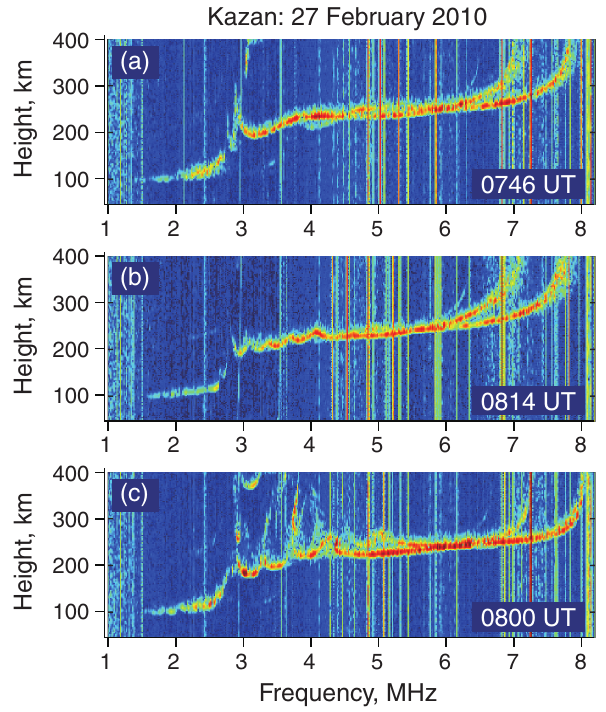
Figure 2. Ionograms obtained at Kazan showing unperturbed traces (a) , weak coseismic disturbances (b) , and a significant anomaly due to large amplitude acoustic waves (c) , corresponding to seis- mic ground motion at Obninsk as shown in Fig.